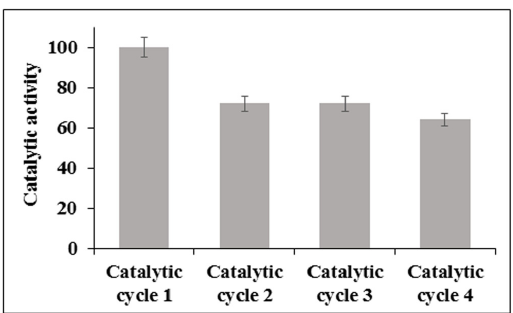
Figure 7. Activity of the catalyst X catalytic cycles.